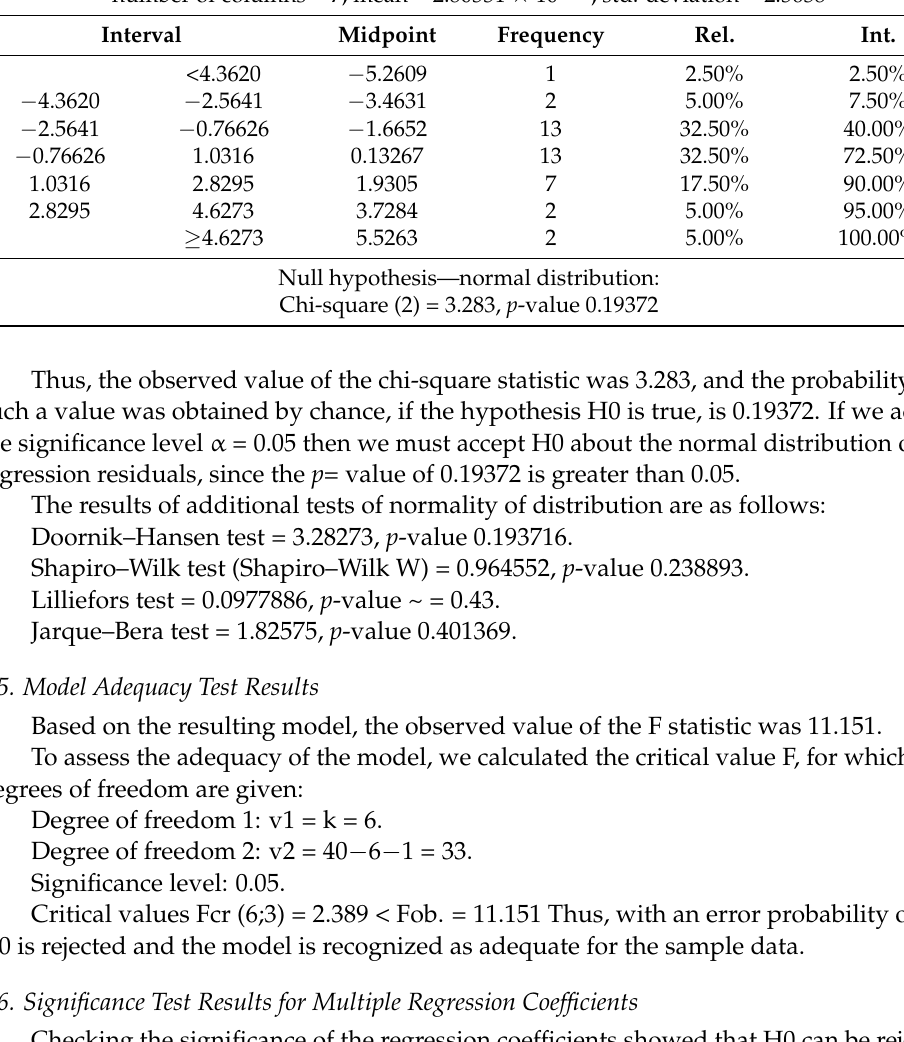
Table 13. Model frequency distribution statistics.